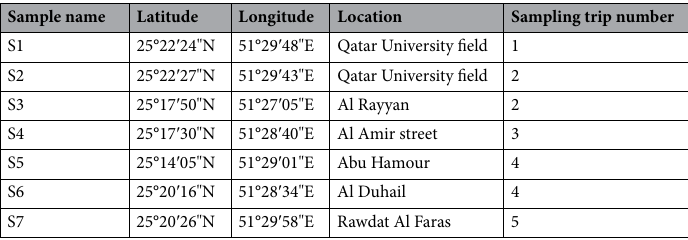
Table 1. Location details of the collection sites of P. juliflora